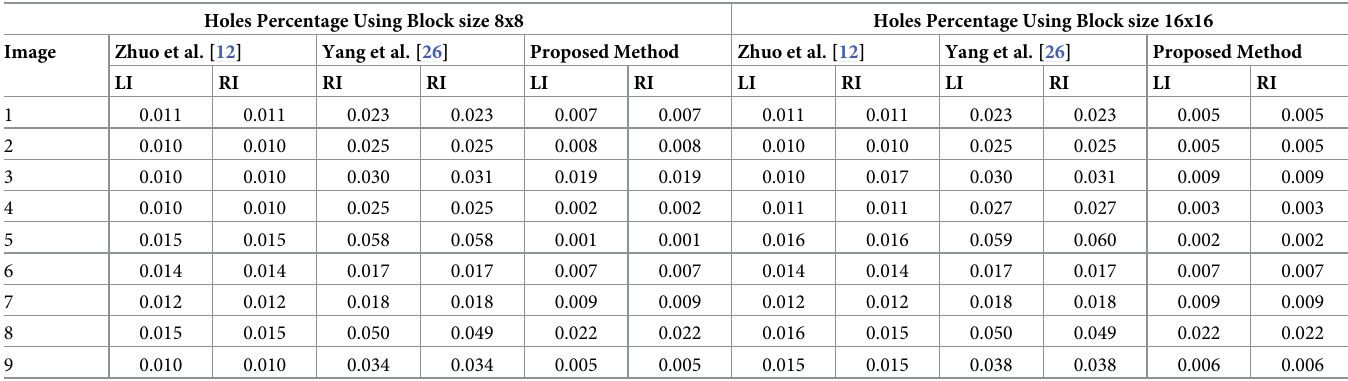
Table 4. Holes percentage using block size 8x8 and block size 16x16 tested dataset [37]. Holes Percentage Using Block size 8x8